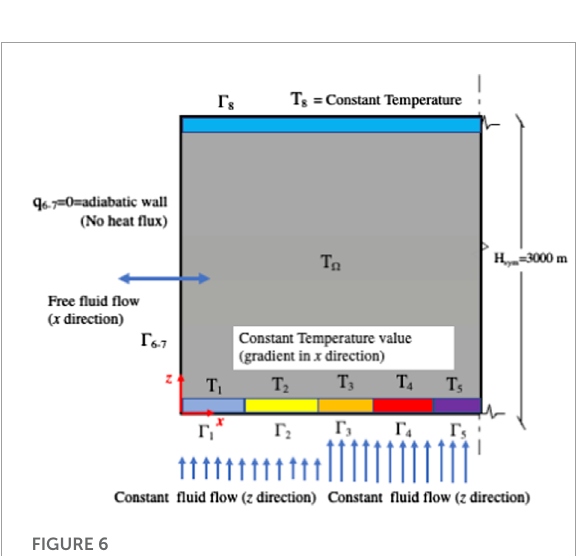
FIGURE 6 Representation of the main boundary and initial condition of the domain.